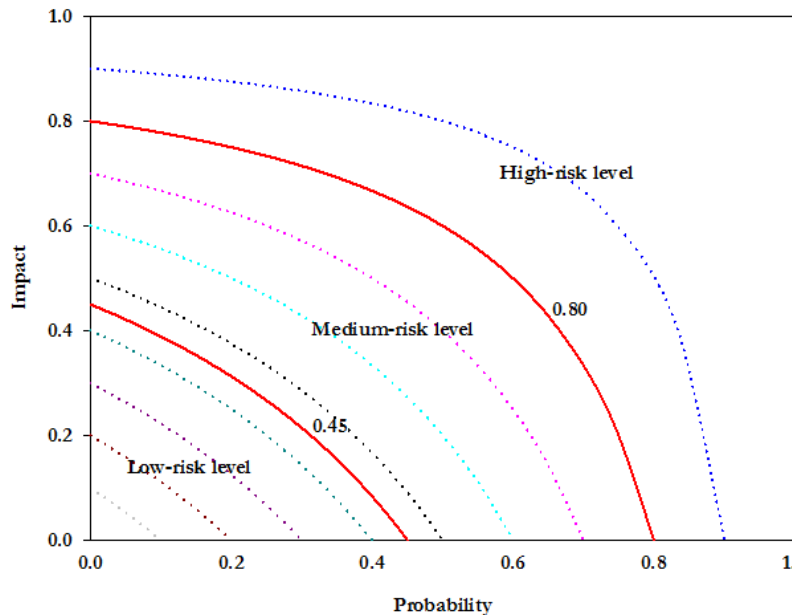
Figure 2. Risk level groups based on impact and probability in risk leveling [10] . Table 2. The case project